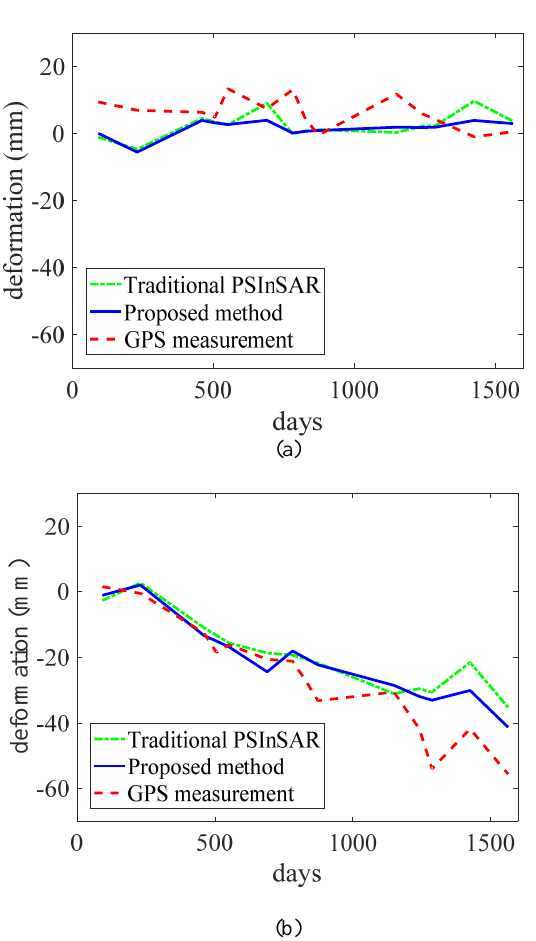
Figure 8. Land deformation estimated using the proposed method: (a) GPS station ID 93025; (b) ID 93027.